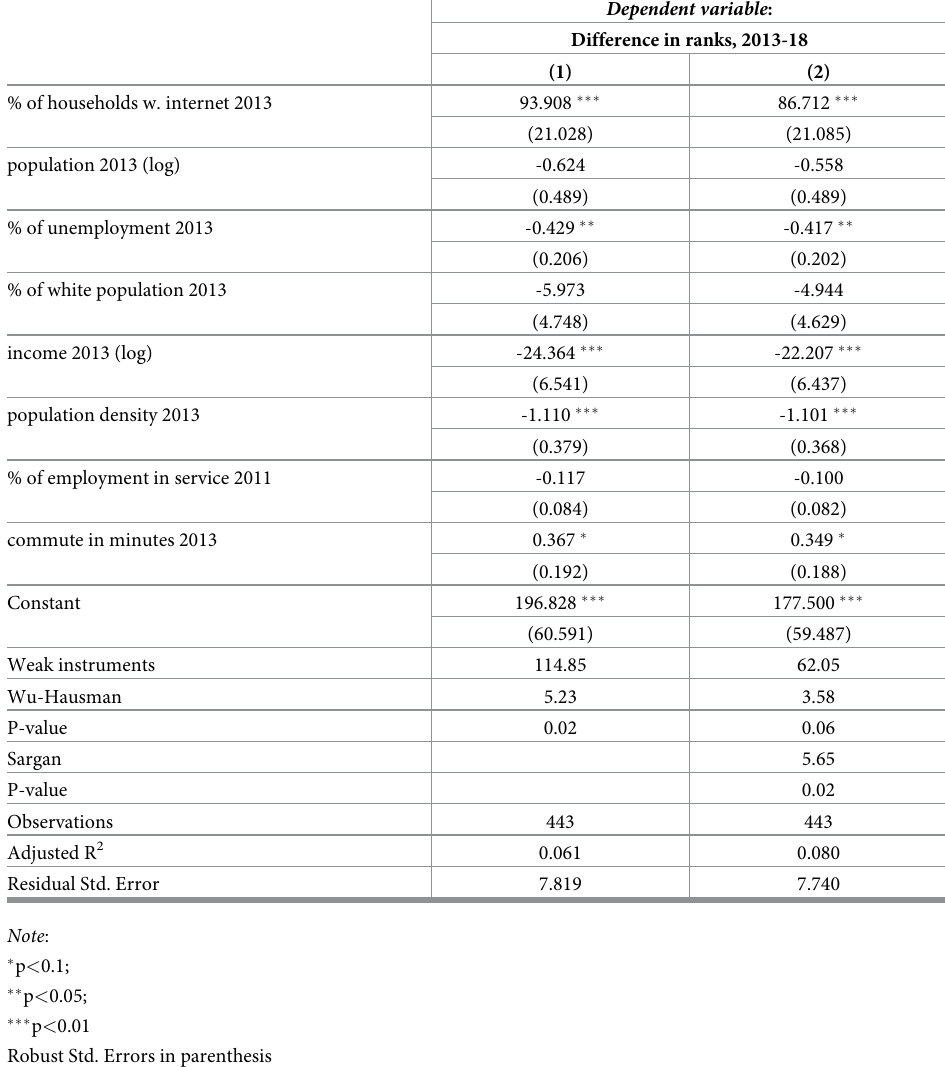
Table 8. 2SLS estimation of Eq (4) for